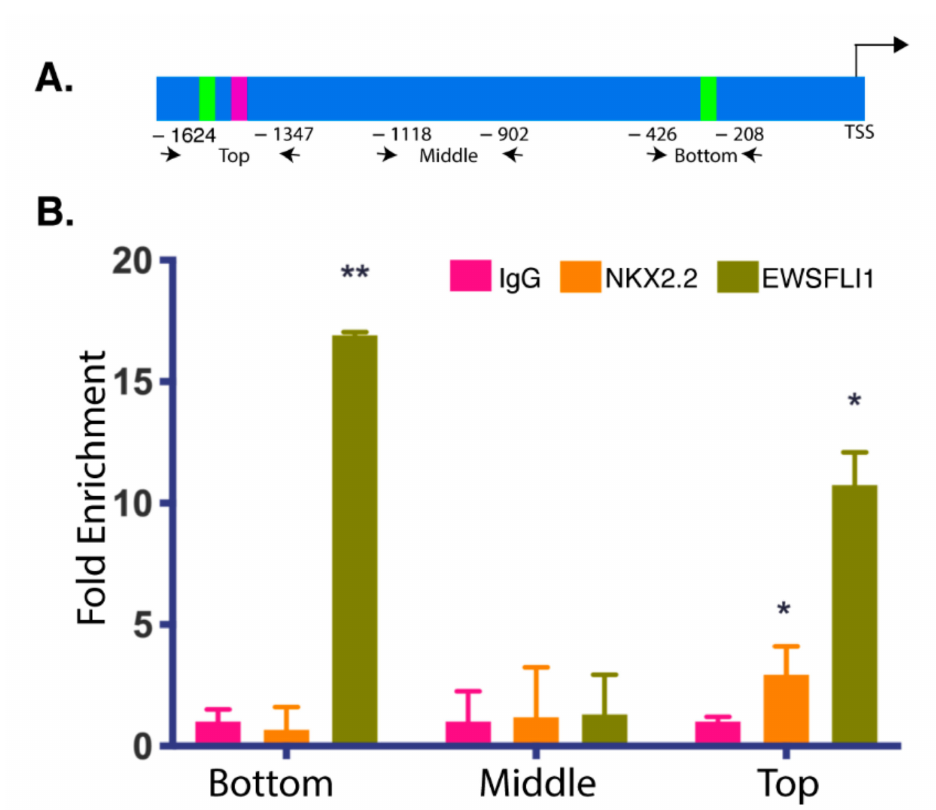
Figure 3. NKX2.2 is associated with the STEAP1 promoter: Chromatin immunoprecipitation (ChIP) of the STEAP1 promoter. ( A ) Graphical representation of binding sites of primers used in ChIP analysis. The numbers represent distance from the transcription start site; not drawn to scale. ( B ) A plot of PCR analyses on the chromatin obtained after pull down with NKX2.2 and EWSFLI1 antibodies from ES cell lysates showing enrichment for both NKX2.2 and EWSFLI1 binding in the top region of the promoter. EWSFLI1 also binds in the bottom region, there is no binding for either transcription factor in middle region. IgG was used as a negative control. Error bars indicate the standard deviation between replicates. * p < 0.05, ** p <